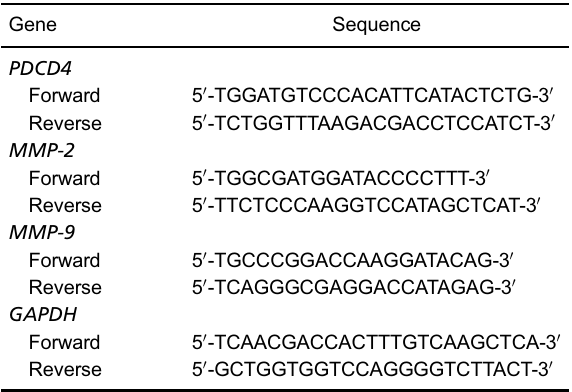
Table 1. Primer sequences of programmed cell death 4 (PDCD4), matrix metalloproteinase-2 (MMP-2), and matrix metalloprotei- nase-9